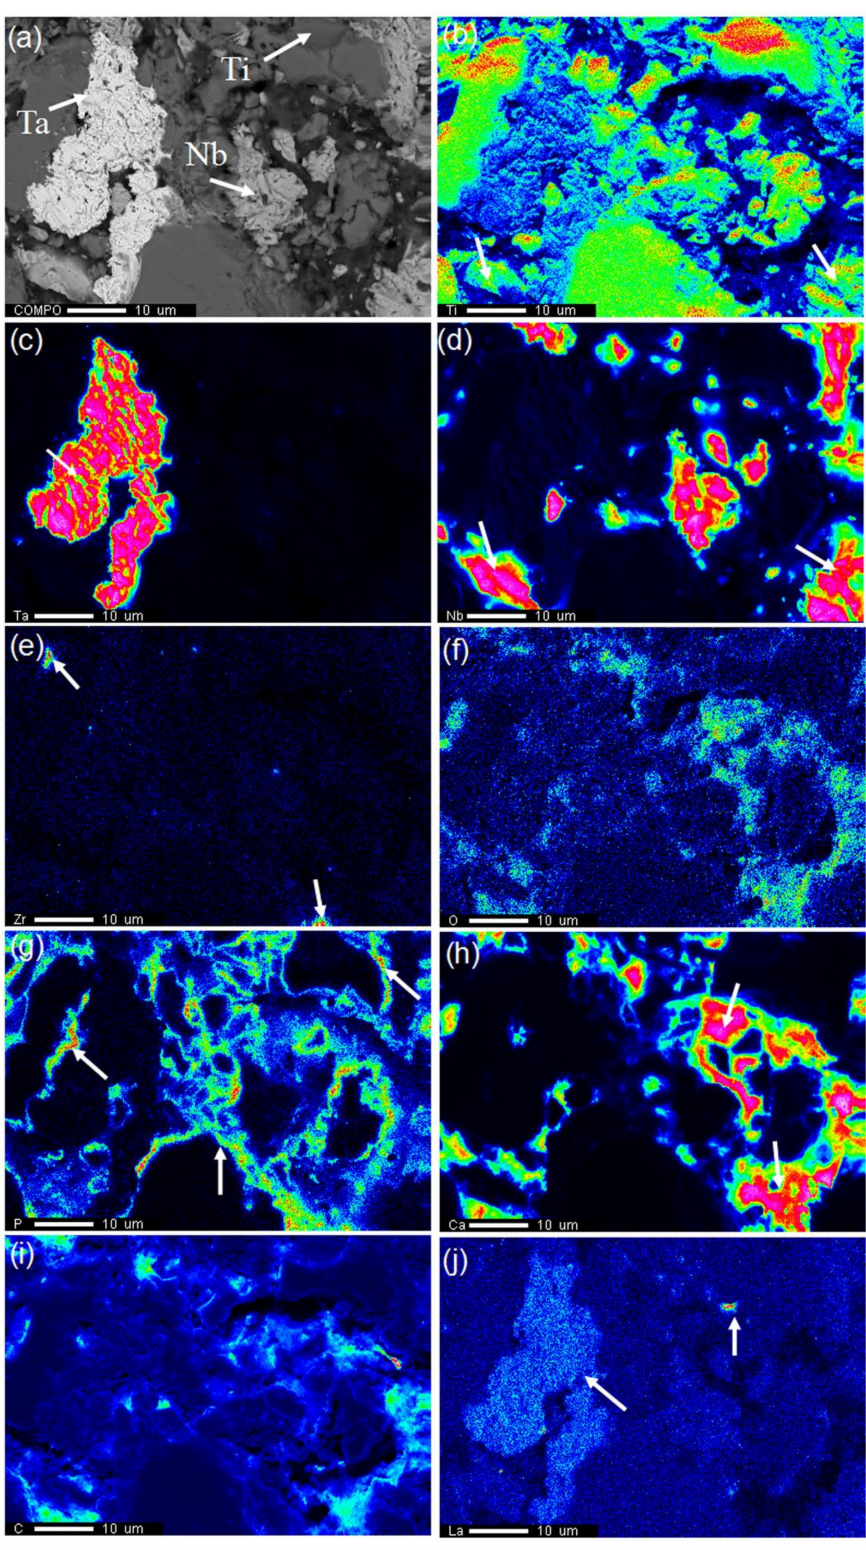
Figure 7. ( a ) SEM micrographs of the 0.5-GNFs nanocomposite sintered at 1000 ◦ C. The corresponding mapping scanning results of electron probe microanalyzer (EPMA): ( b ) Ti; ( c ) Ta; ( d ) Nb; ( e ) Zr; ( f ) O; ( g ) P; ( h ) Ca; ( i ) C; and ( j )